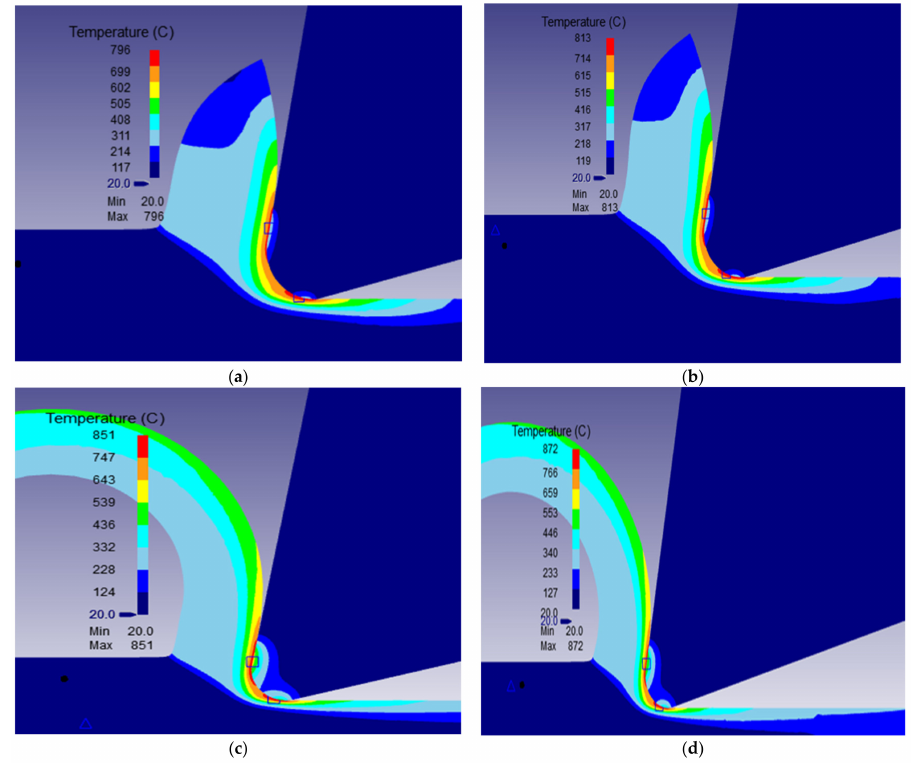
Figure 5. Distribution of cutting temperature in the workpiece and cutting tool at V = 400 m/min, f = 0.1 mm/rev, γ = 5 ◦ for the nose radii r c : ( a ) 0.3 mm, ( b ) 0.5 mm ( c ) 0.7 mm and ( d ) 0.9